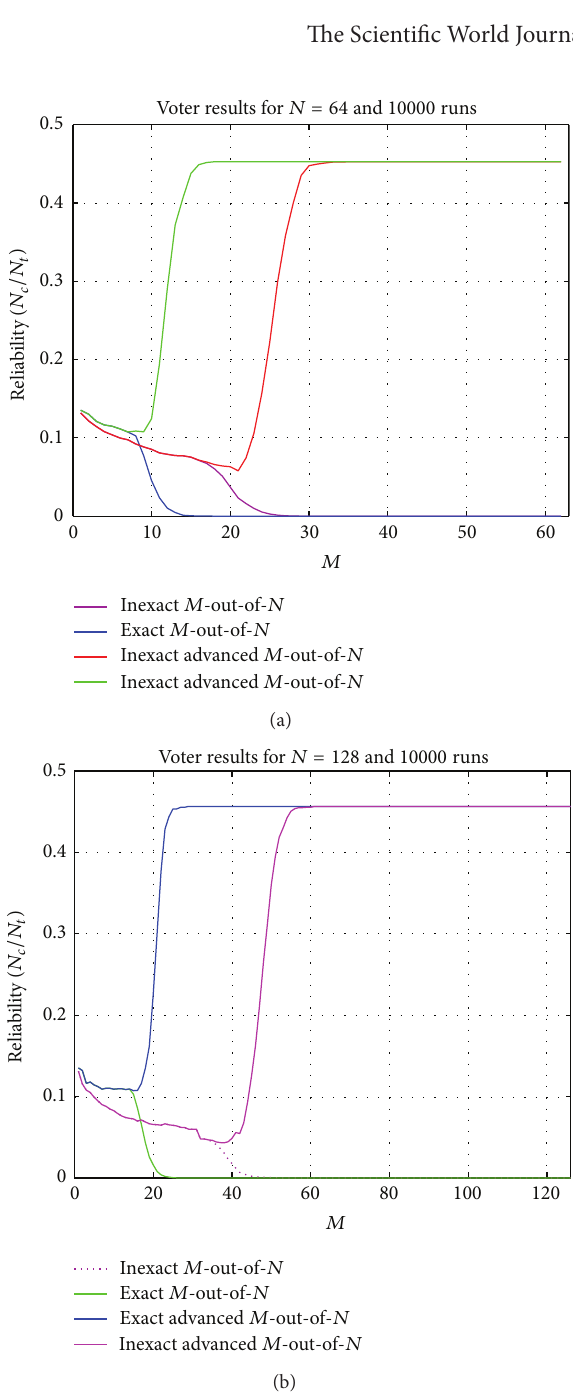
Figure 2: The percentage of agreed results of voting algorithms for (a) 𝑁 = 64 and (b) 𝑁 = 128 . Figure 3: The percentage of correct agreements (reliability) of voting algorithms for (a) 𝑁 = 64 and (b) 𝑁 = 128